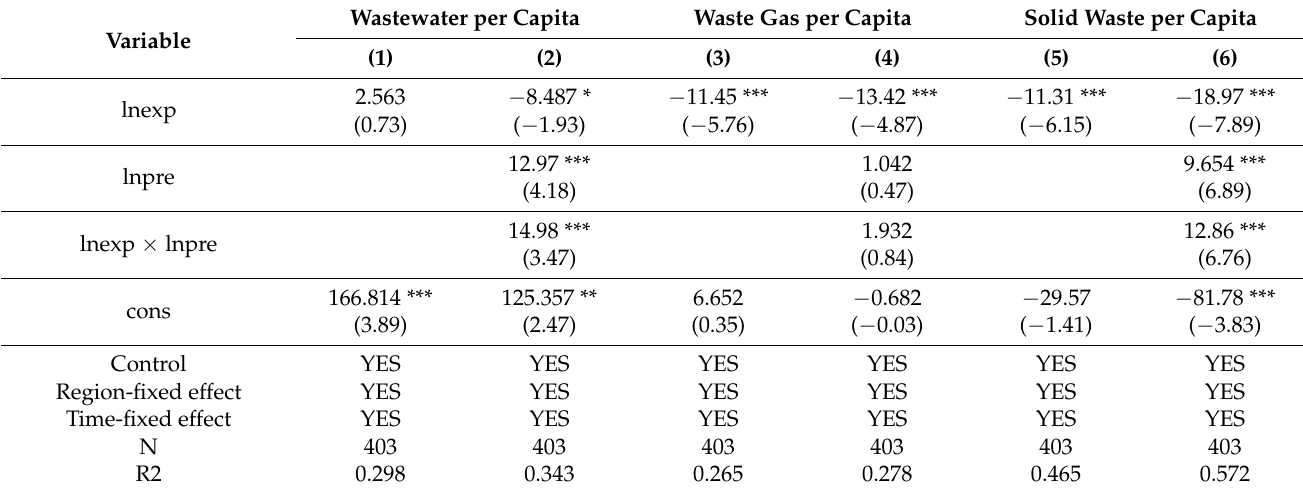
Table 8. Impact of fiscal pressure on pollution reduction effect of fiscal expenditure